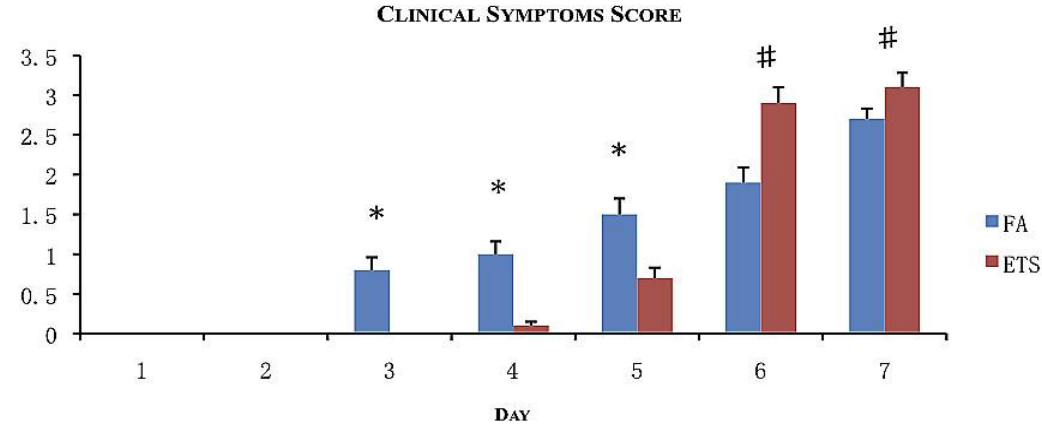
Figure 3. Morbidity assessment following viral inoculation with exposure to filtered air (FA) or environmental tobacco smoke (ETS). Clinical scores were calculated by assigning one point for every sign of illness observed for 7 days following viral inoculation. Data is presented as the group mean (n = 20) ± SEM. * indicates a significantly increased degree of clinical scoring compared to ETS day-matched exposure groups ( p < 0.05). # indicates a significantly increased degree of clinical scoring compared to FA day-matched exposure groups ( p <